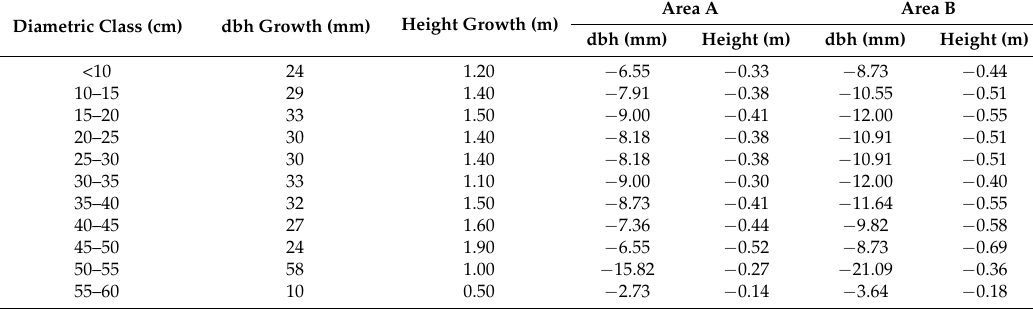
Table 1. Values of tree diameter at breast height (dbh) and height growth between the second National Forest Inventory (NFI2) and the third one (NFI3) (11 years) and subtractive values of dbh and height when applying linear interpolated degrowth to match Airborne Laser Scanning (ALS)